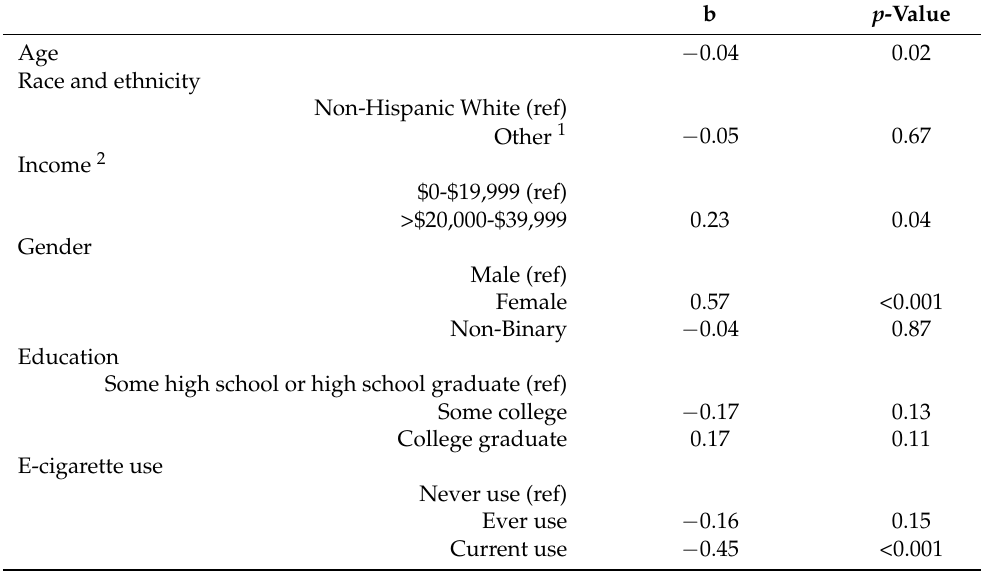
Table 4. Unadjusted associations of e-cigarette harm perceptions and